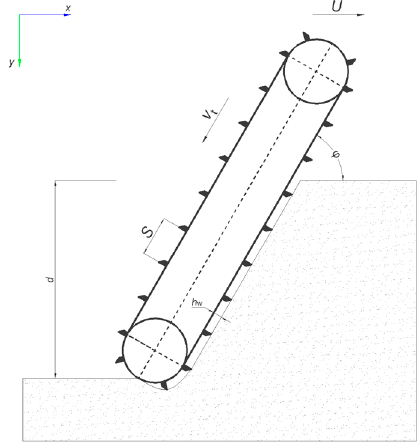
Figure 5. Kinematic parameters of a chain saw [24].